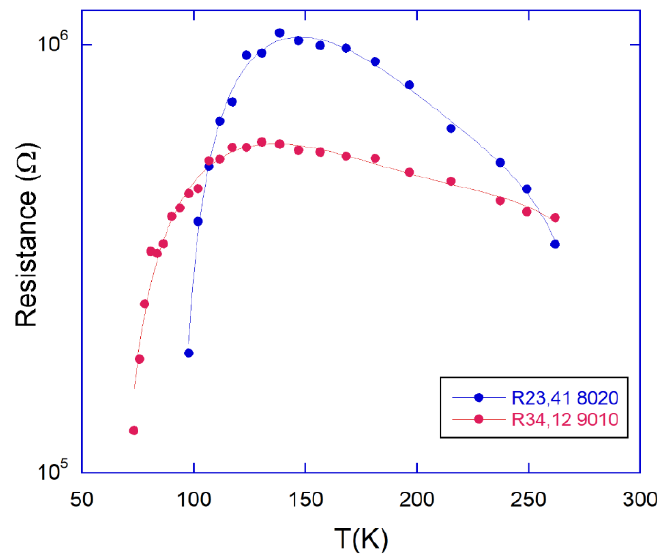
Figure A2. A plot of logarithmic resistance versus temperature of the R 23,41 measurement of sample 2T-8020 and the R 34,12 measurement of sample 2T-9010. Table A1. Extrapolated possible values for Tc , as resistance maxima in temperature curves. MEASUREMENT Stage